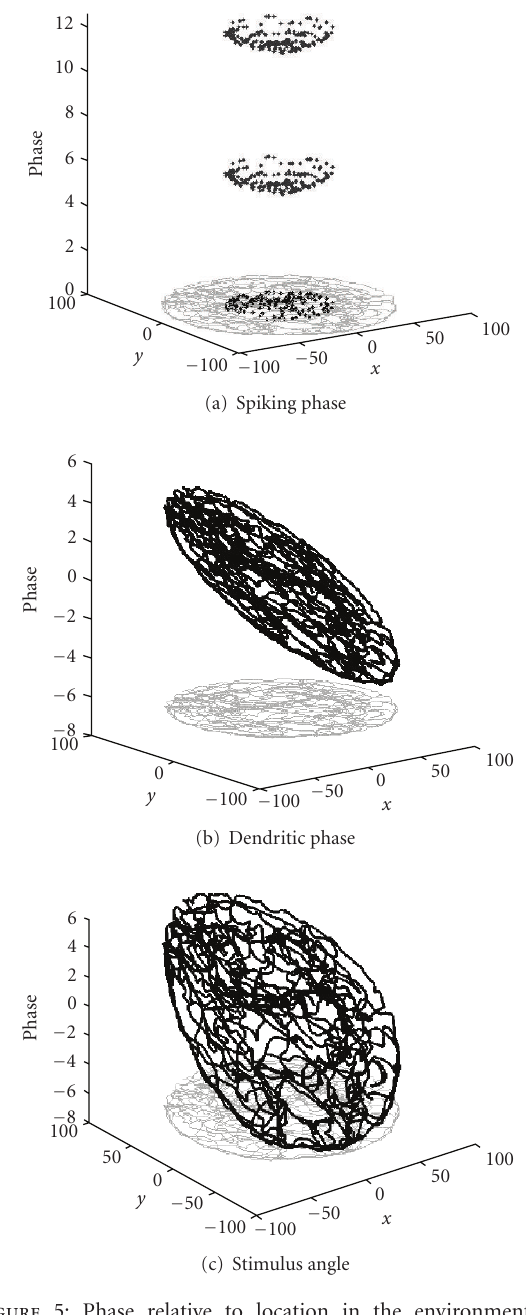
Figure 5: Phase relative to location in the environment. (a) Spiking phase due to precession (with refractory period). Note that phase depends upon location, but is circularly symmetric. (b) Dendritic phase of oscillations contains more complete continuous representation of location. (c) Plot of the angle of a single distal visual stimulus as a rat moves around in an environment, indicating similarity of allocentric stimulus angle to integrated dendritic phase in a grid